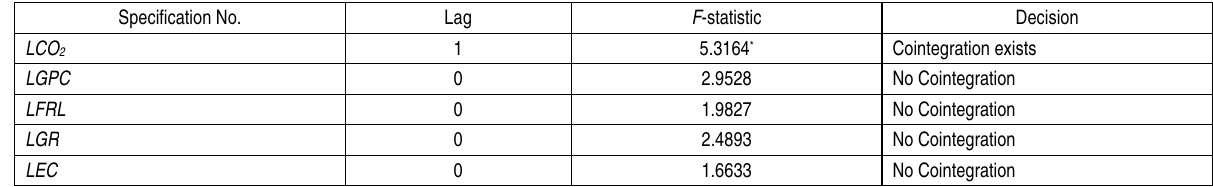
Table 3. Cointegration test results (1972-2013)